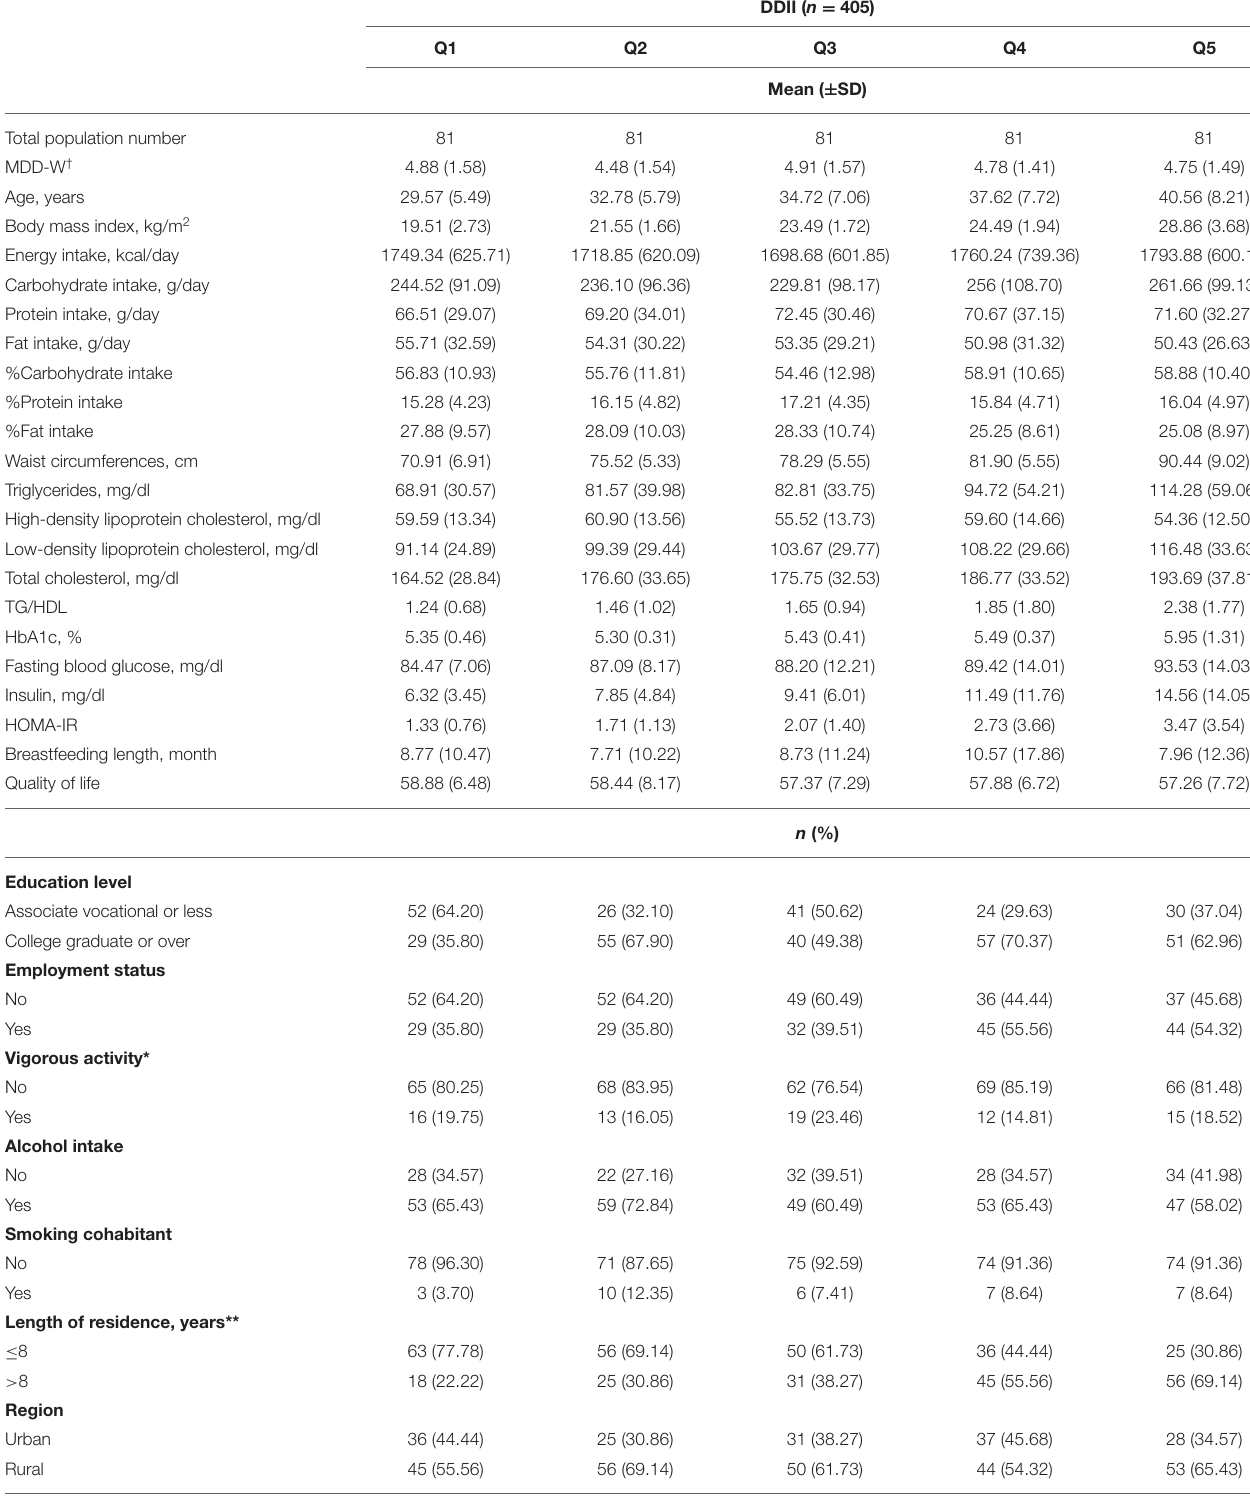
TABLE 2 | Baseline characteristics according to the quintiles of DDII in the FiLWHEL